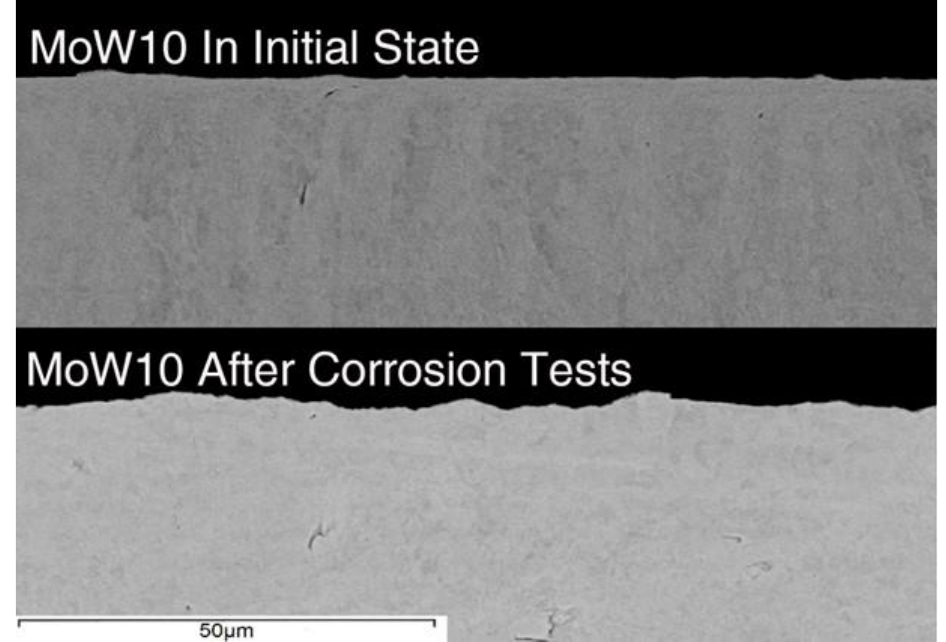
Figure 3. BSE-SEM images of microstructure of MoW10 alloy samples before and after contact with BLA at 650 °C for 100 h.